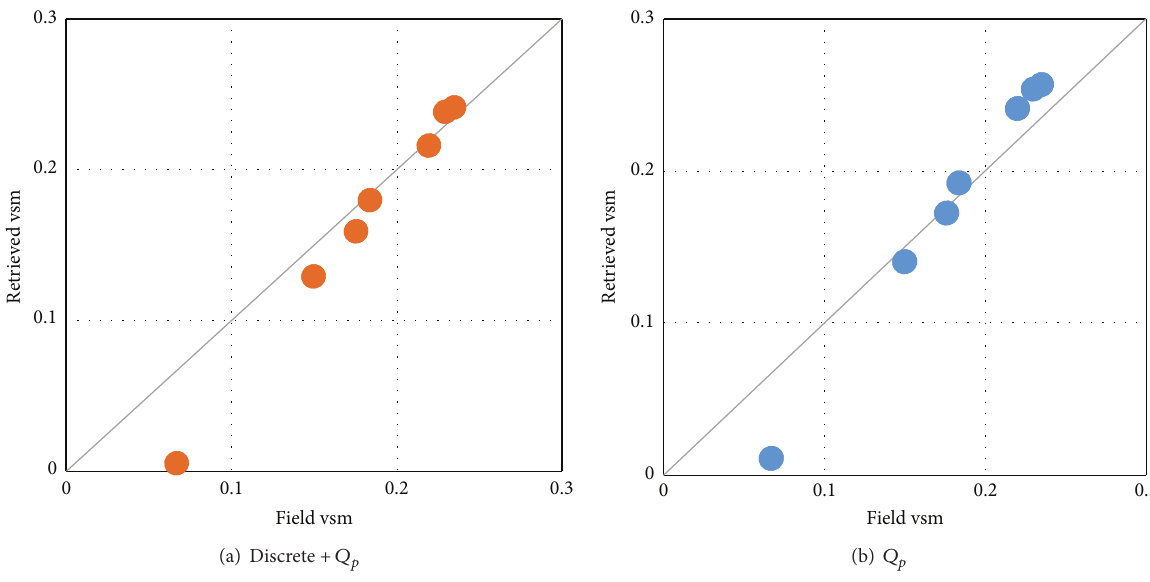
Figure 6: Field and retrieved volumetric soil moisture (cm 3 /cm 3 ).